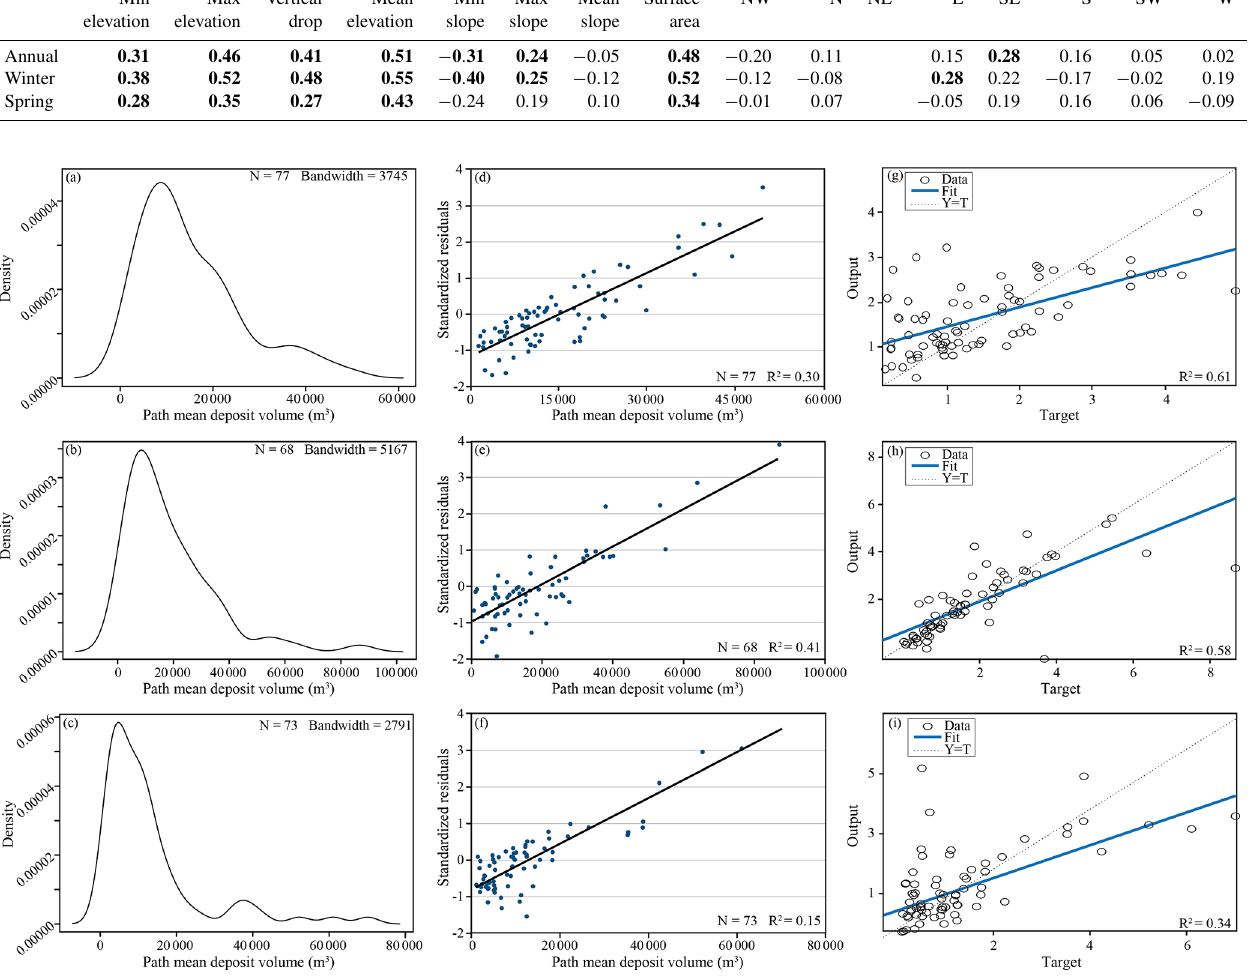
Figure 2. Statistical characteristics of snow avalanche deposit volumes. Kernel density estimation of mean path deposit volumes at the annual November–June timescale (a) , in winter, November–February (b) and in spring, March–June (c) . Standardized residuals of stepwise linear regression results between path mean deposit volumes and path morphological variables for annual (d) , winter, (e) , and spring (f) . Linear correlation between observed deposit volume and values predicted by one neural network for the annual (g) , winter (h) , and spring (i) dataset ( Y is predictor and T is